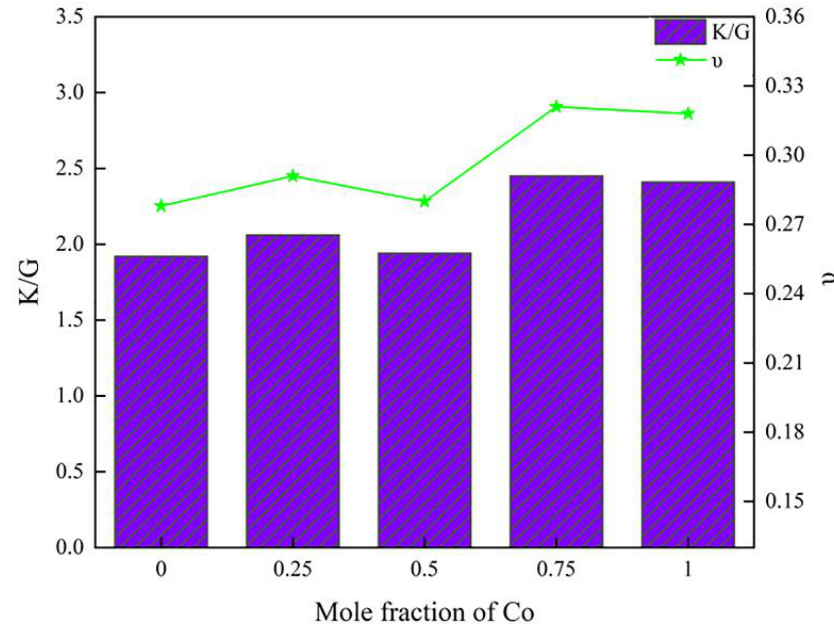
Figure 3. The calculated K / G and υ of AlCo x CrFeNi (x = 0, 0.25, 0.5, 0.75, 1) HEAs.